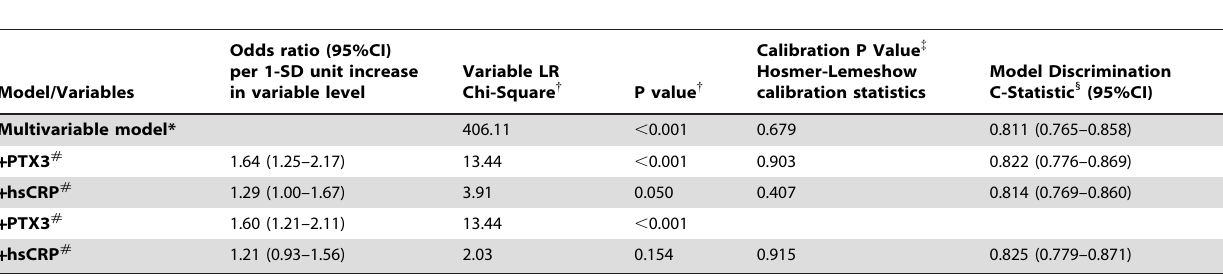
Table 5. Contribution of PTX3 and C-reactive protein level or the combination of the two to the risk prediction of prevalent cardiovascular